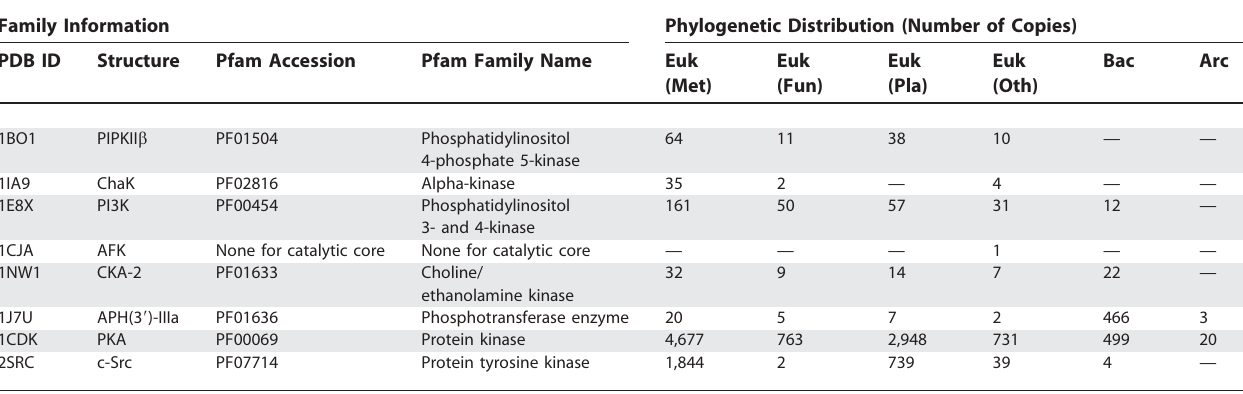
Table 3. Phylogenetic Distribution of Kinase Families within the Superfamily, According to the Pfam Resource Family Information Phylogenetic Distribution (Number of Copies)